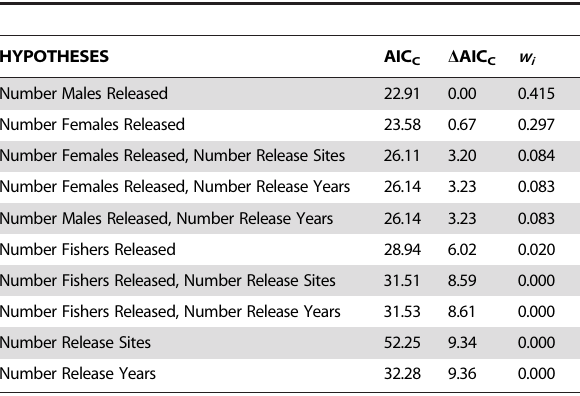
Table 6. Hypotheses generated by the results of our VORTEX simulations and their ranking using AIC C1 .